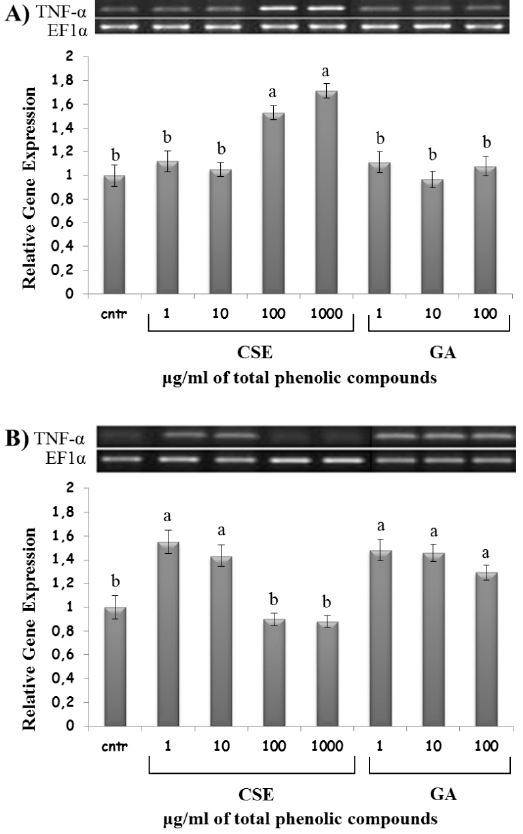
Figure 8. TNF- α mRNA expression in response to different doses of CSE and GA in in vitro incubations